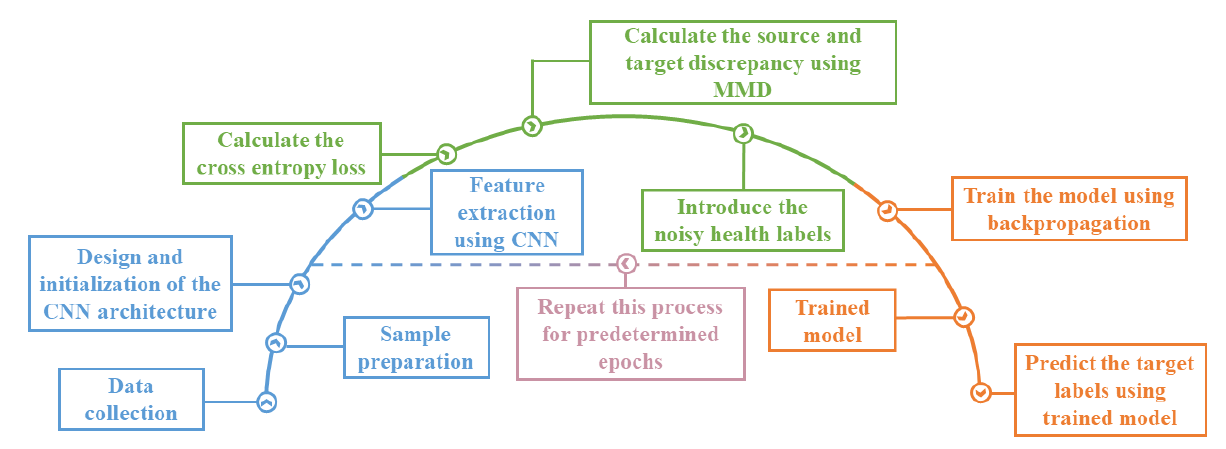
Figure 4. The flowchart of the proposed deep learning